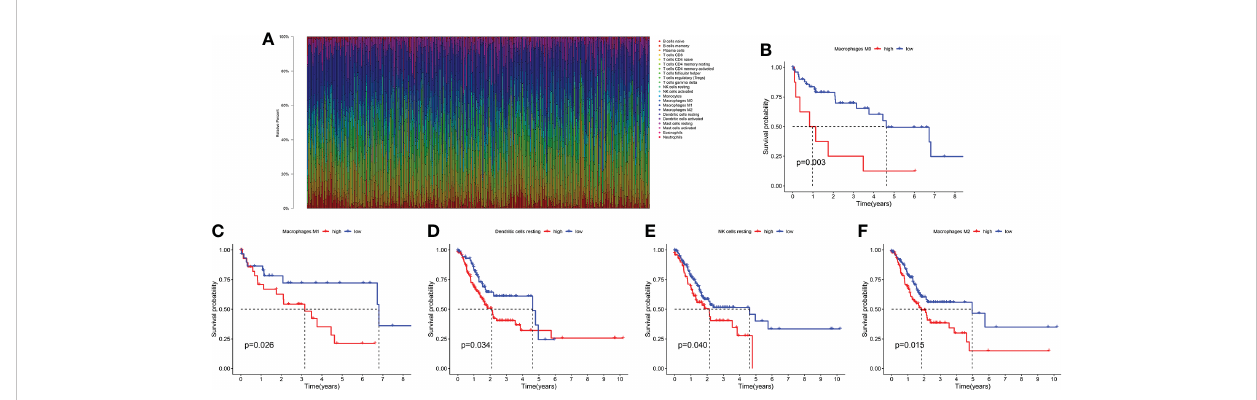
FIGURE 2 The survival signi fi cance of 22 immune in fi ltrating cells in LIHC. (A) Quanti fi cation of the in fi ltration levels of 22 immune cells in the TCGA cohort. (B) The survival signi fi cance of macrophages M0. (C) The survival signi fi cance of macrophages M1. (D) The survival signi fi cance of dendritic cells resting. (E) The survival signi fi cance of NK cells resting. (F) The survival signi fi cance of macrophages